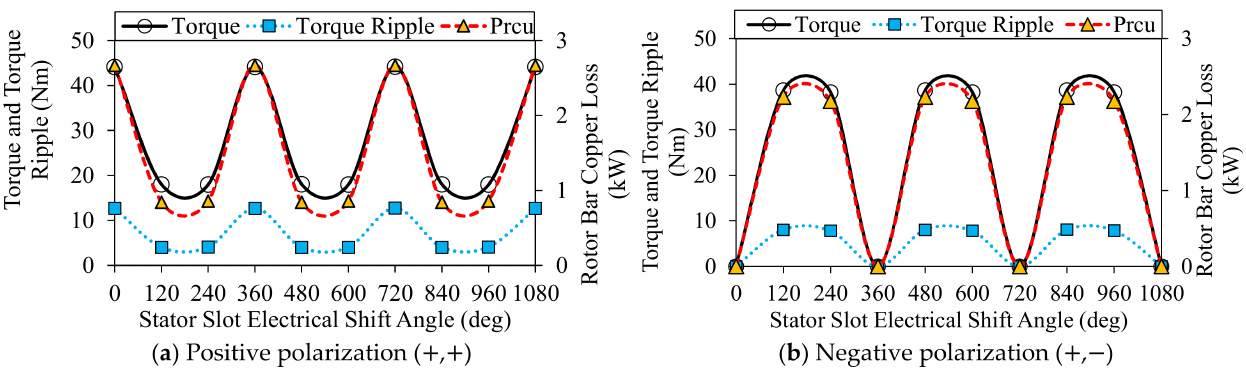
Figure 3. Variation of winding harmonics with α : ( a ) low-order and ( b ) high-order.